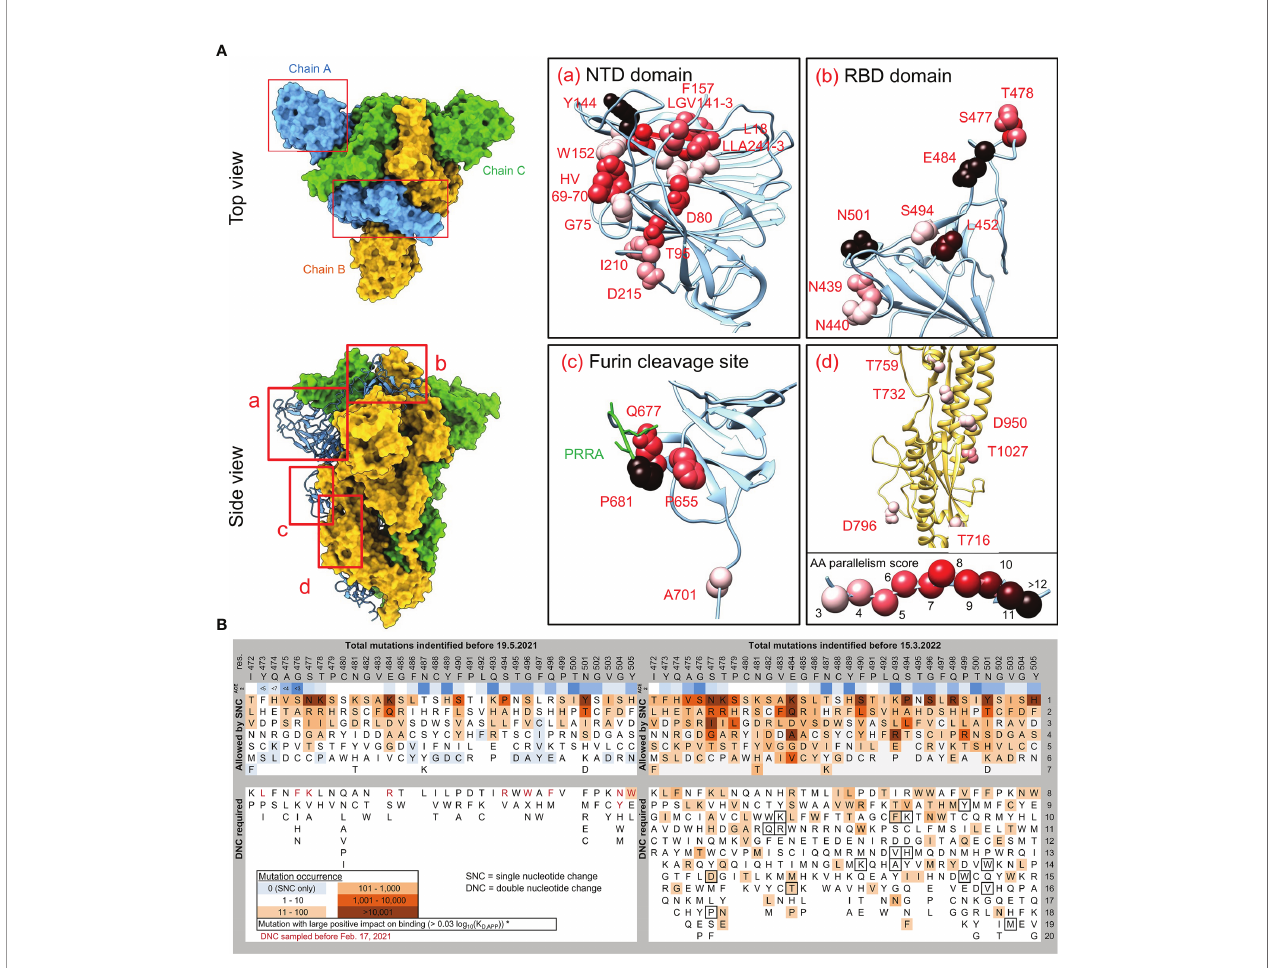
FIGURE 2 | Localization of convergent mutations in SARS-CoV-2 S-protein structure, breakdown and progression of RBD AA mutations. (A) The S-protein parts missing in the crystal structure (PDB ID: 6zge) were modelled by the Modeller suite implemented in UCSF Chimera 1.13.1 (Webb and Sali, 2016). Residues under convergent evolution are depicted in spheres representation and colored according to their parallelism scores ( Figure 1 ). Inset d) shows the region covering a portion of heptad repeat, central helix, and b -hairpin domains. Green residues in inset c) highlight the Furin cleavage site. (B) The mutational sequence space of RBD binding interface residues 472 – 505, and its coverage by mutations present in the GISAID database. All possible SNC (single-nucleotide change) AA substitutions are depicted. For TNC (two-nucleotide change) substitutions, only the subset of AA substitutions that were sampled in GISAID are depicted (in background color scale according to the legend), together with substitutions with a positive binding impact (frame). The AA position is invariant to its later occurrence to highlight differences. Deep-mutational scanning D